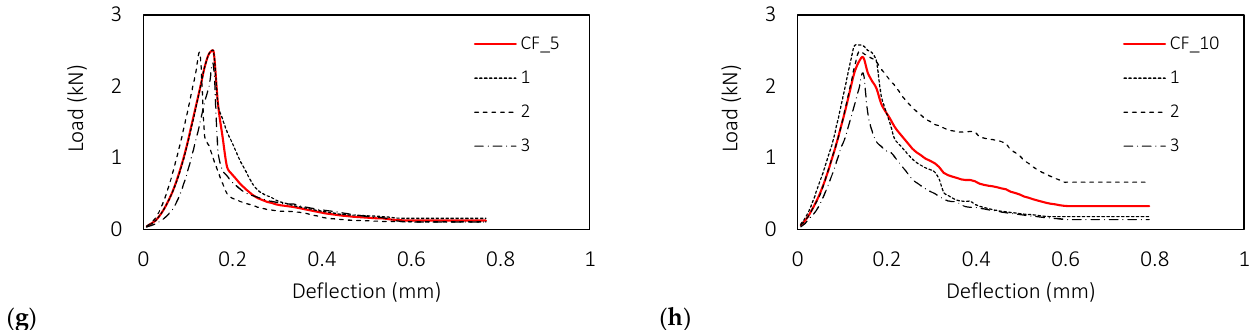
Figure 5. Influence of fibre type and length on toughness of fibre reinforced mortars: ( a ) referent